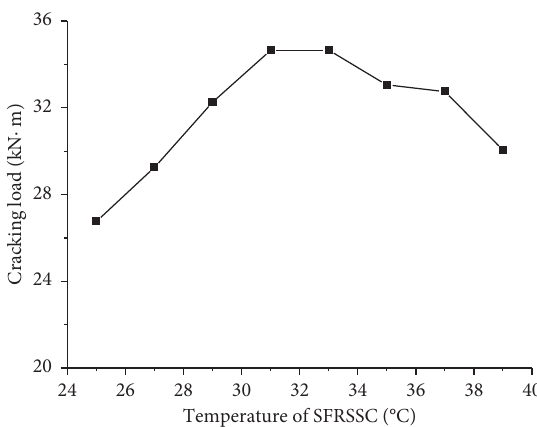
Figure 30: Relationship between cracking load and temperature.